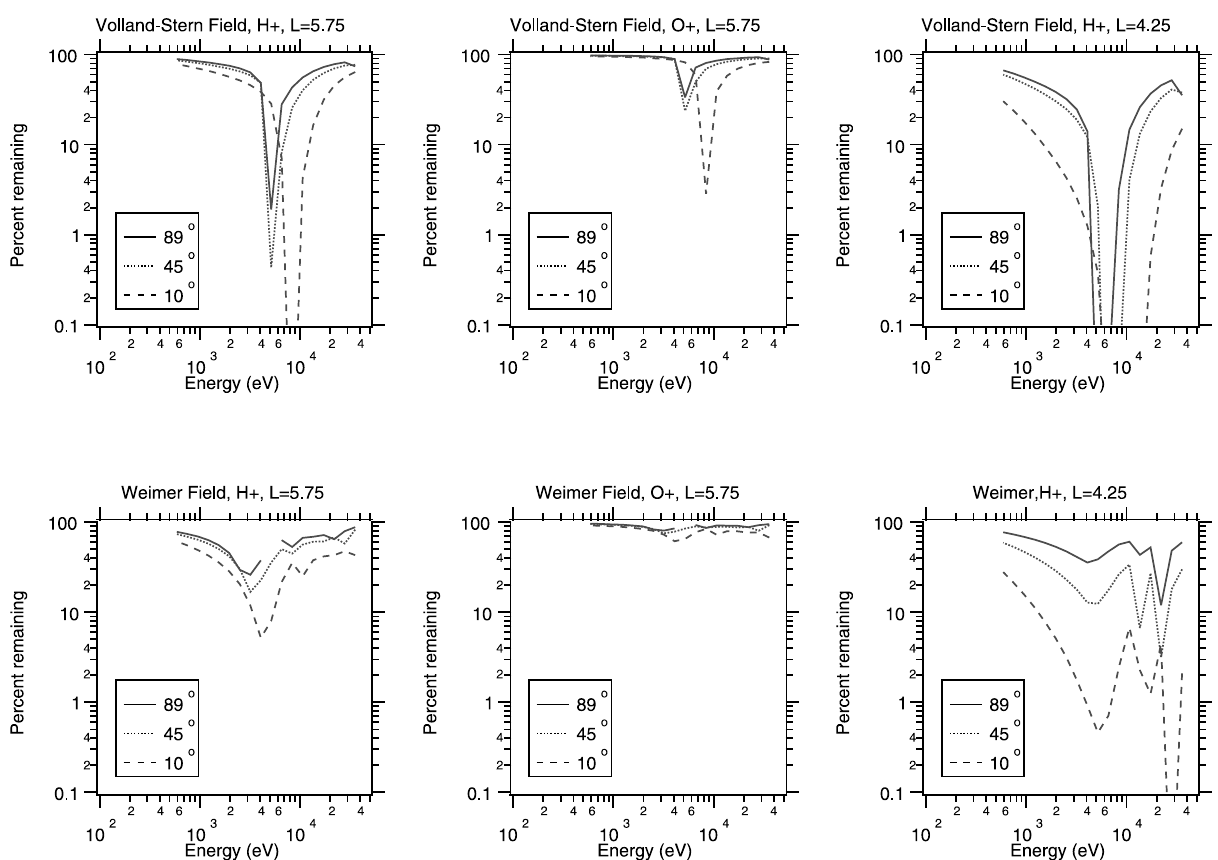
electric field, and the bottom panels assume convection in a Weimer electric field. Charge exchange with the neutral hydrogen geocorona is the only loss